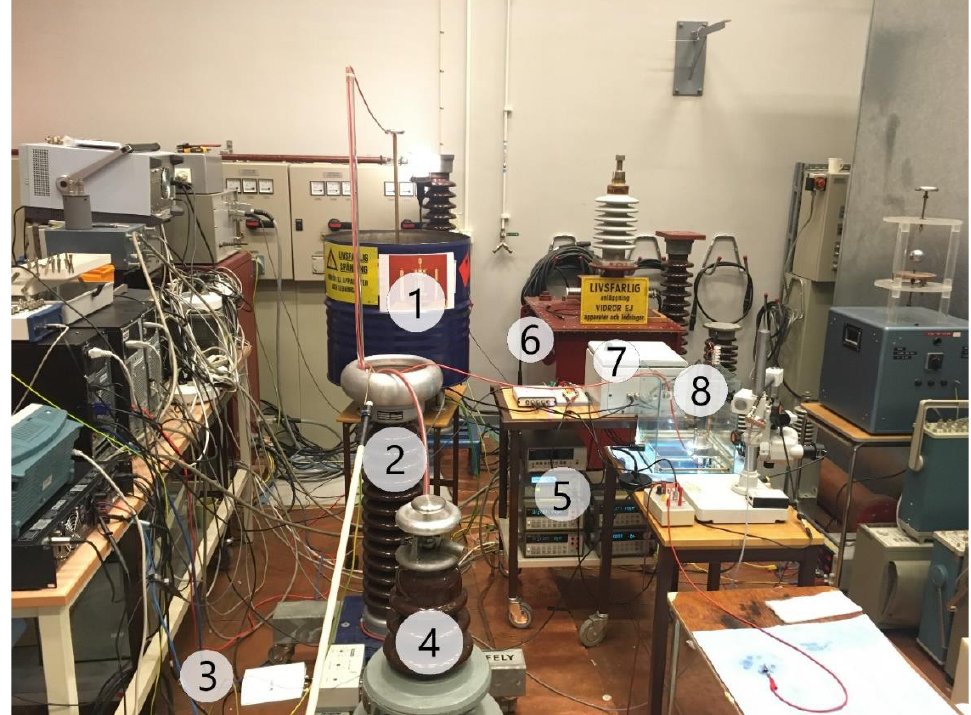
Figure 7. The setup which facilitated the electrical tree inception experiments. (1) Voltage divider, (2) coupling capacitor, (3) NI-5133, (4) transformer, (5) signal generation and RTD-measurement, (6) NI-4431, (7) reference impedance, and (8) test cell submerged in oil.